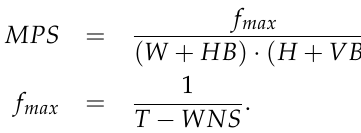
Table 2. Maximum processing speeds for different video resolutions. The symbol # denotes quantities. Video Resolution